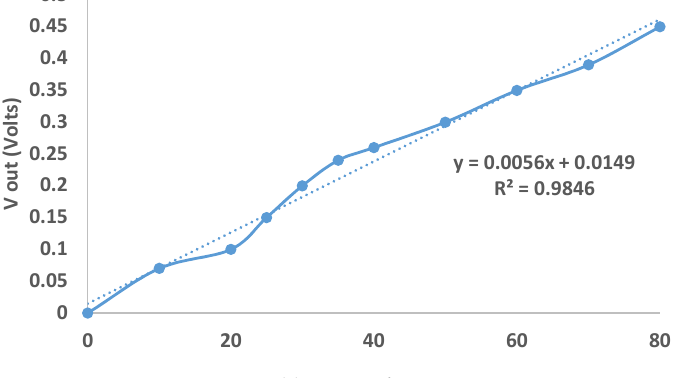
Wind Speed (Km/h) Figure 11. Calibration of anemometer. Figure 11. Calibration of anemometer.